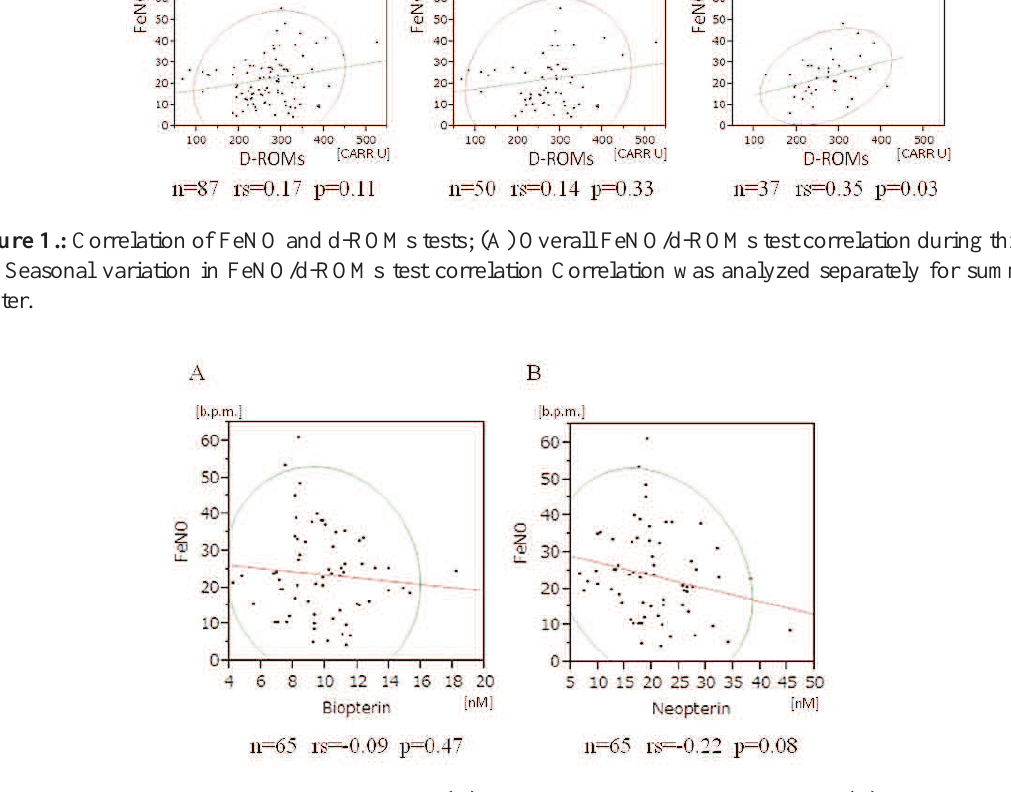
Figure 2.: Correlation of FeNO and pteridines; (A) Correlation of FeNO and biopterin; (B) Correlation of FeNO and neopterin relation Correlation was analyzed separately for summer and